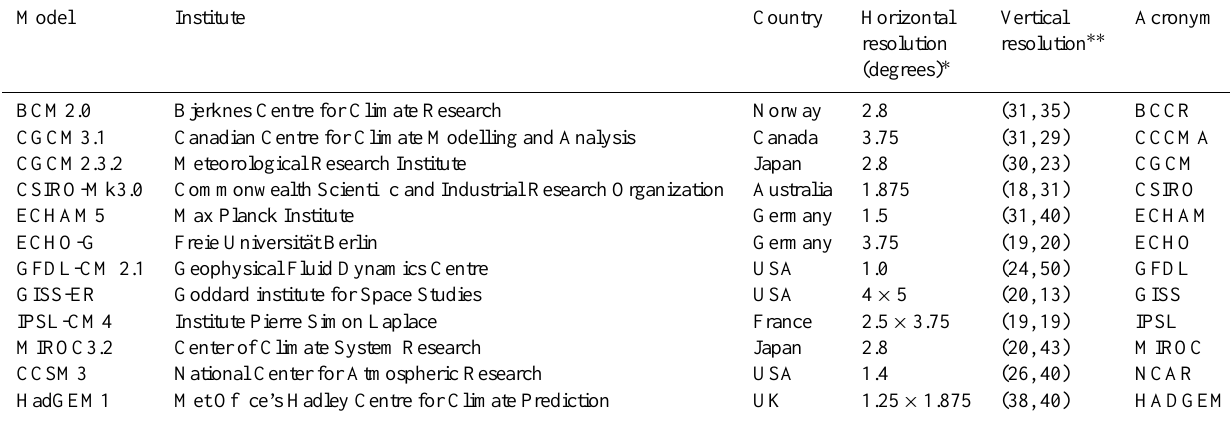
Table 1. Overview of selected